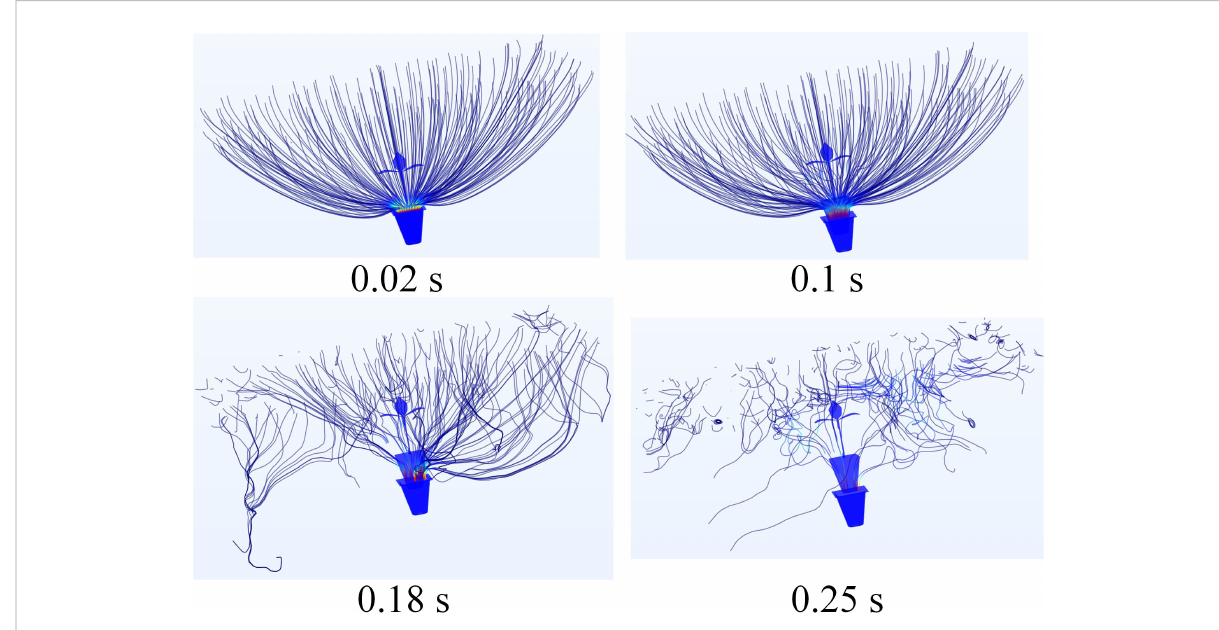
FIGURE 8 Distribution of fl ow fi eld in different time periods when air fl ow pressure is 0.4